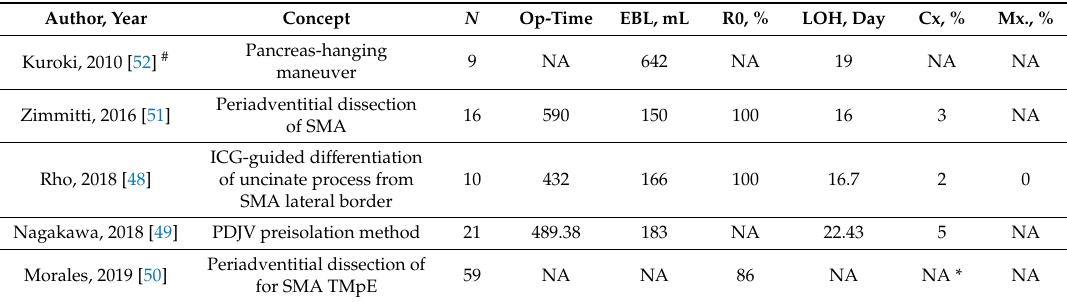
Table 3. Several approaches to obtain clear SMA lateral margin.